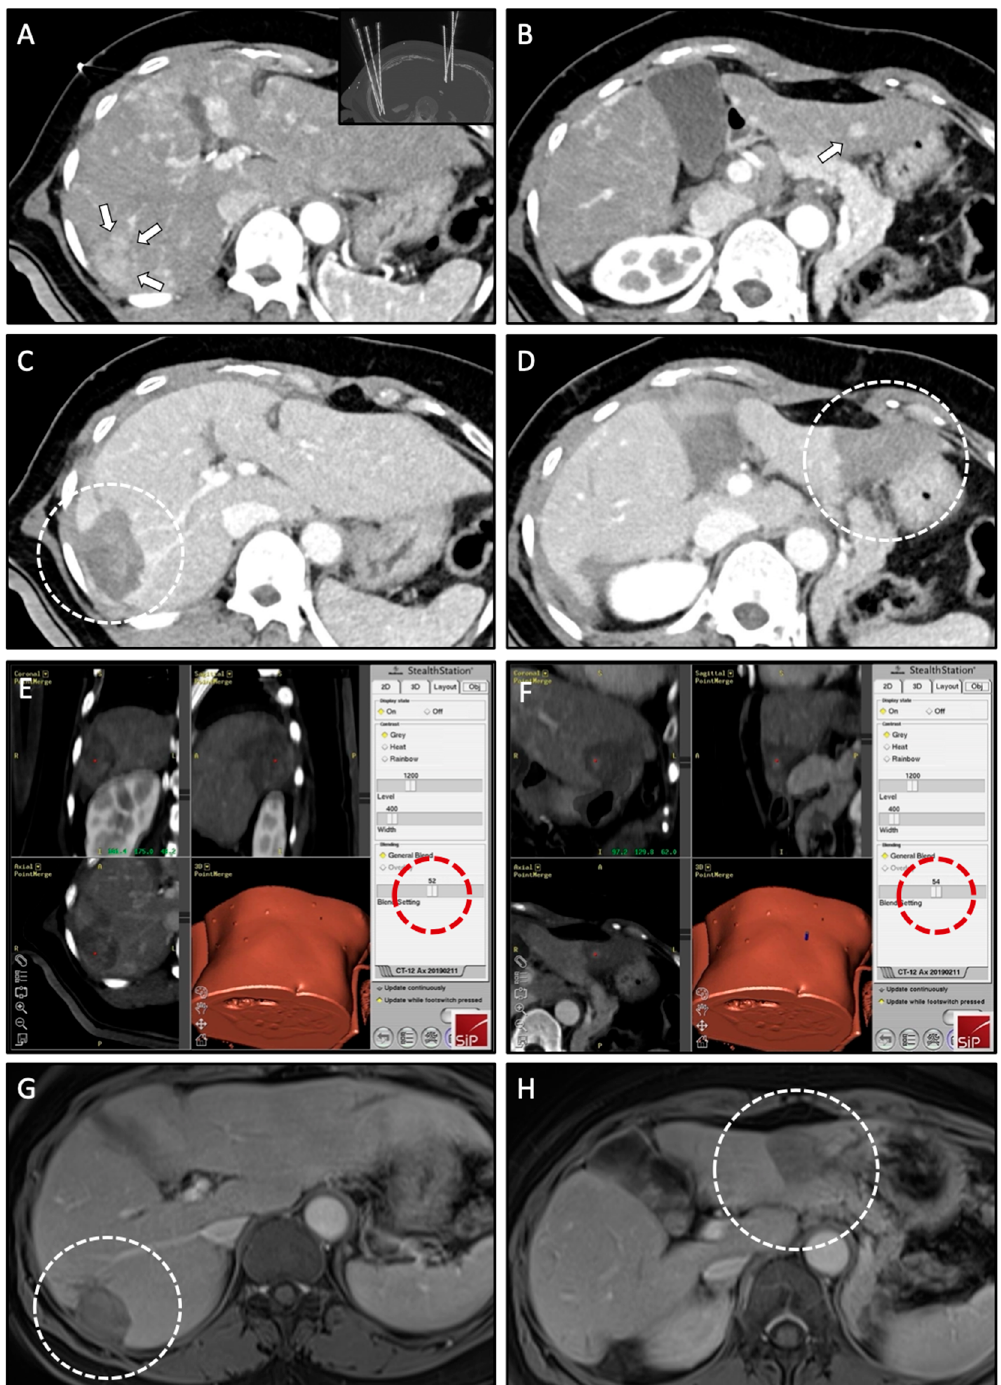
Figure 3. Case of a 57-year-old male with simultaneous treatment of two HCCs (right and left liver lobe) using SRFA. ( A , B ) Planning CT scan in arterial phase of the SRFA procedure with a 30-mm HCC nodule in liver segment VI (white arrows) and a 9-mm HCC nodule in liver segment III (white arrow); Maximum Intensity Projection (MIP) of the non-enhanced control CT scan showing the position of seven coaxial needles in the upper right corner of ( A ). ( C , D ) Control CT scan after ablation with corresponding necrosis zones in liver segment VI and III (white dashed circles). ( E , F ) Three-dimensional views of the intraprocedural image fusion of the contrast-enhanced planning and final control CT scan using the rigid-registration tool from the navigation system with the possibility to switch between images using the blending function (red dashed circle); verification of complete necrosis including a sufficient safety margin. ( G , H ) Follow-up MRI scan 18 months after SRFA, showing no evidence of LTP with shrinking necrosis zones (white dashed circle)